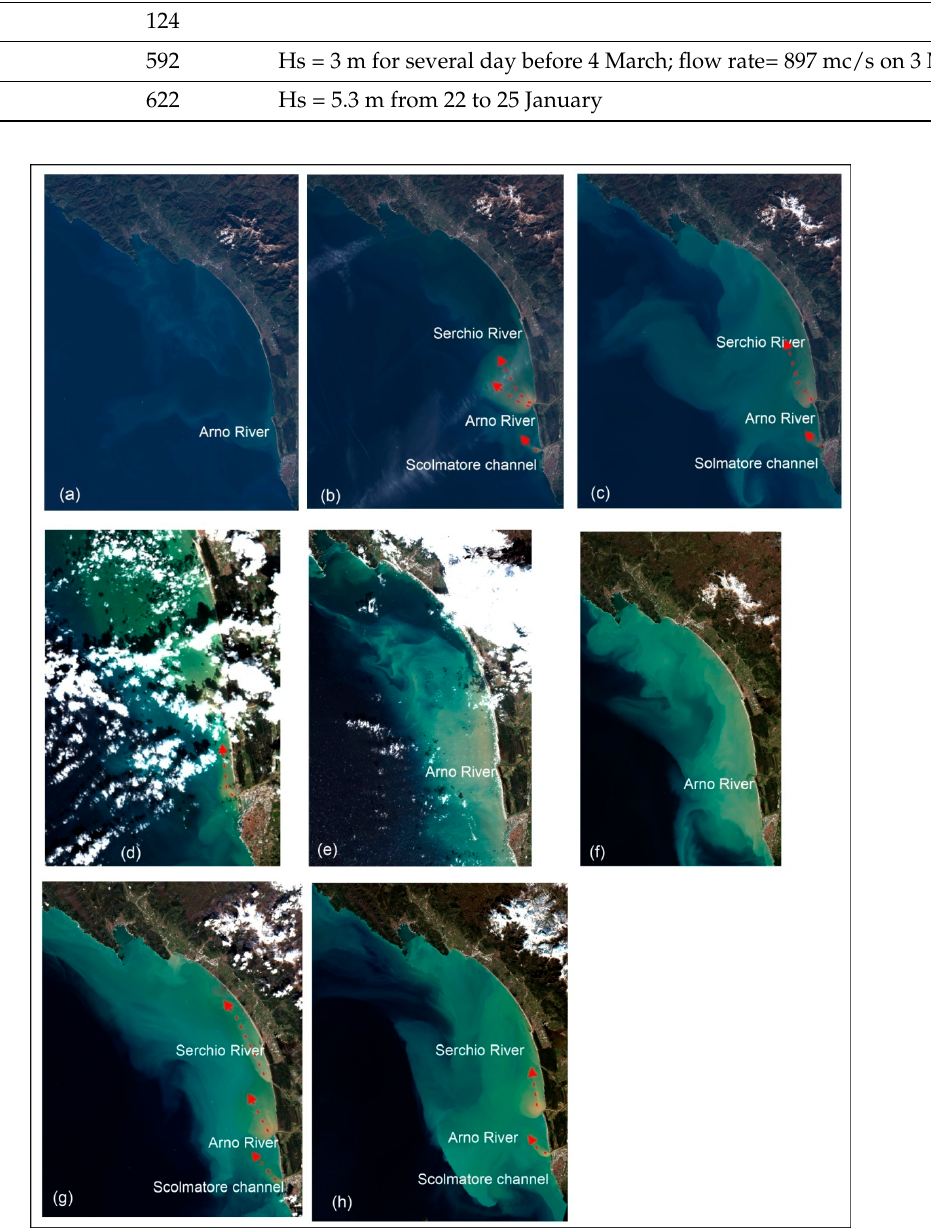
Figure 10. The Sentinel 2 images show the plumes of the Arno River, Serchio River and Scolmatore channel during daily condition ( a ) and flooding events occurred on 26 February 2017 ( b ), 8 March 2021 ( h ). The red arrows indicate the main direction of plume